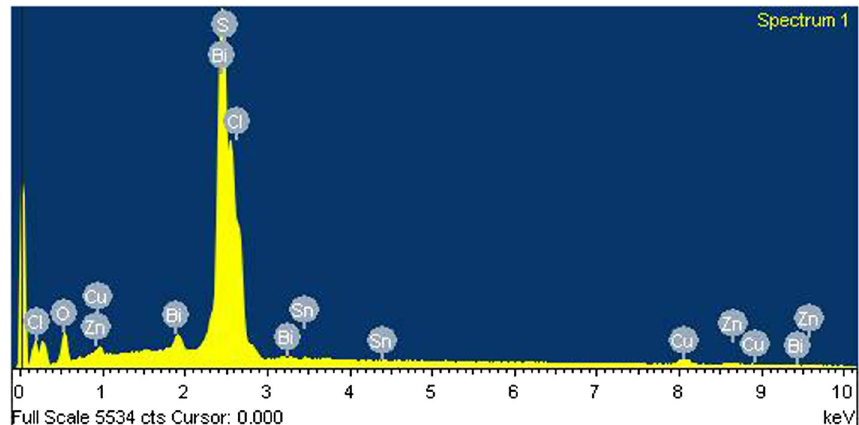
Fig. 3 EDX spectra of BiOCl– Cu 2 ZnSnS 4